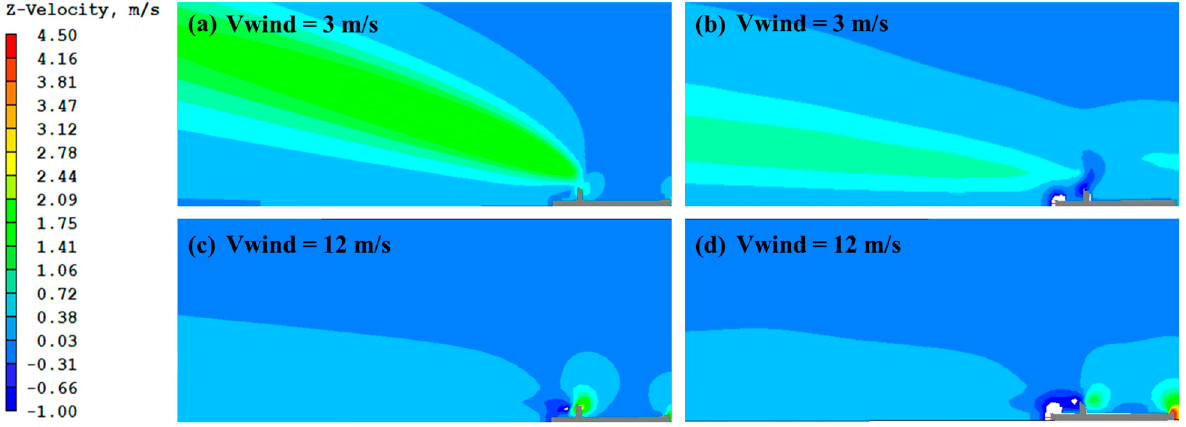
Figure 8. The vertical velocity contours in the S4 − V2 − T2 scenario: ( a ) stationary source when the wind speed is 3 m/s; ( b ) moving source when the wind speed is 3 m/s; ( c ) stationary source when the wind speed is 12 m/s; and ( d ) moving source when the wind speed is 12 m/s.